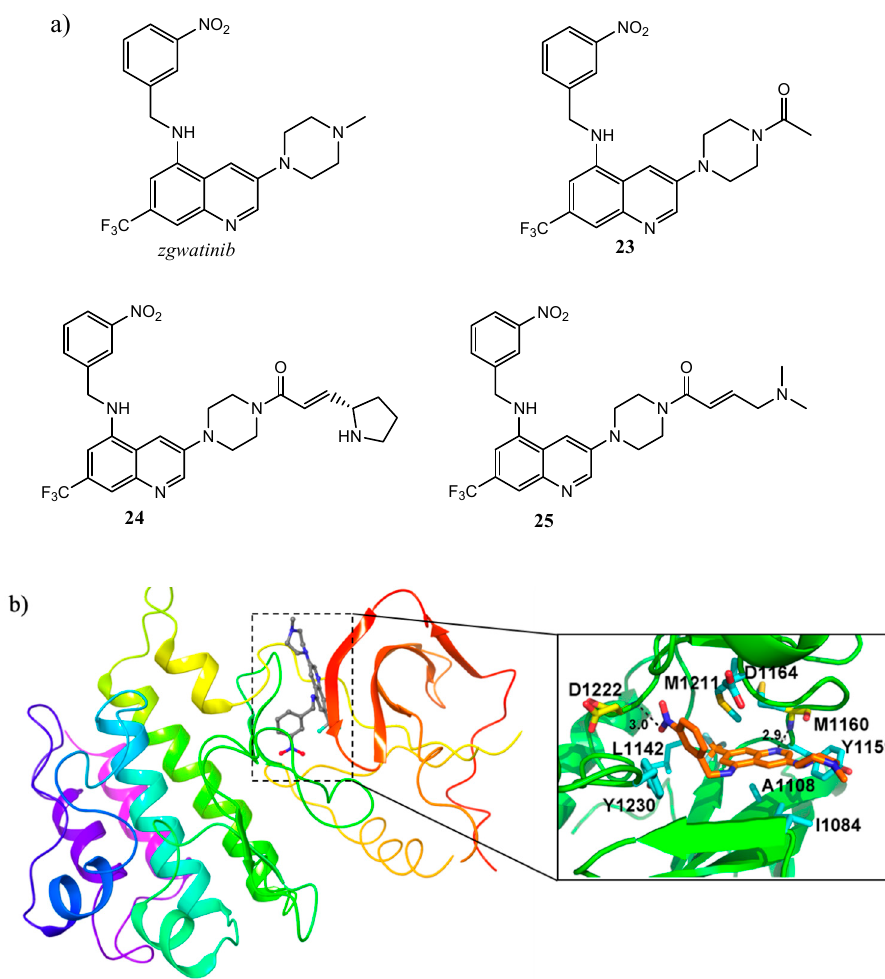
Figure 7. ( a ) structures of a new cluster of 3,5,7-trisubstituted quinoline compounds with promising anticancer activity on c-Met [55,57]; ( b ) crystal structure of zgwatinib in complex with the kinase domain of c-Met (residues coloured in cyan form hydrophobic interactions with the ligand, whereas those coloured in yellow formed H-bonds, indicated with black dash lines; PDB id: 4GG5), [56].